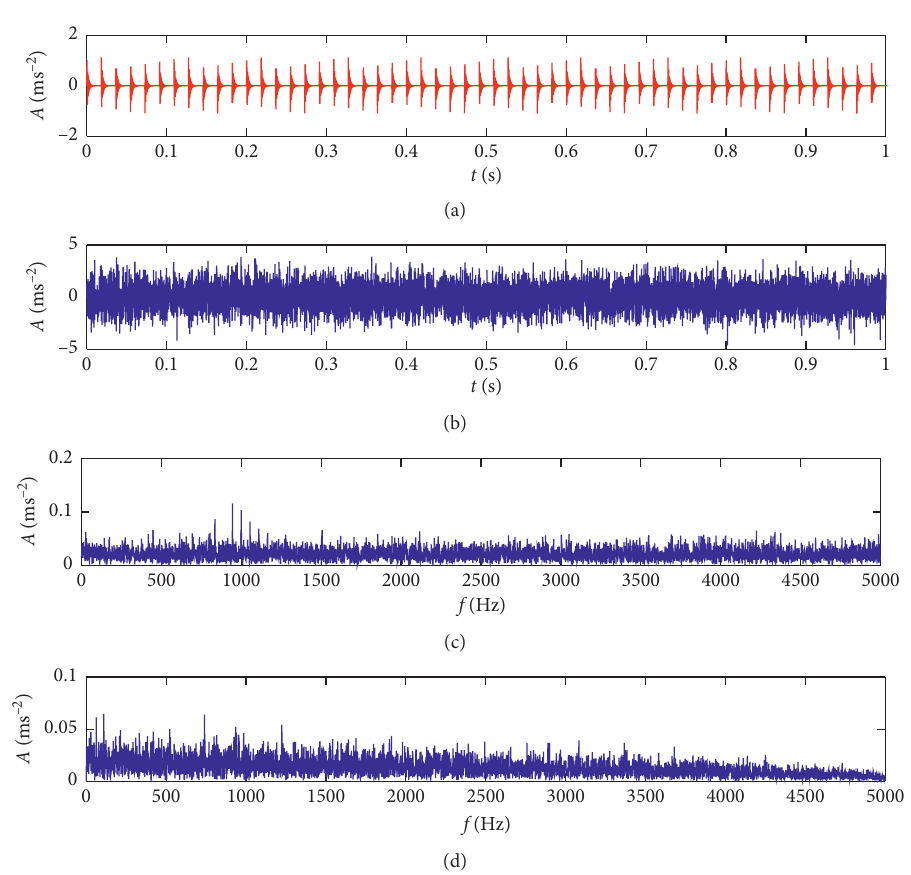
Figure 5: (a) Simulation signal without noise; (b) simulation signal with noise; (c) spectrum; (d) envelope